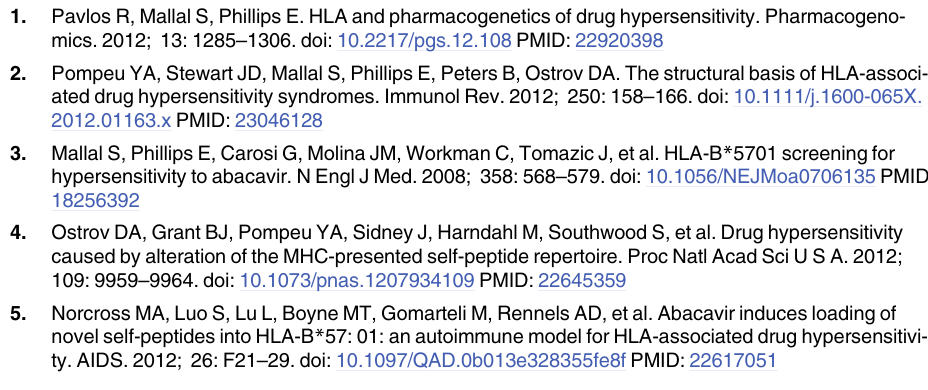
S3 Fig. Effect of seven drugs on binding specificity of HLA-B (cid:1) 57:01. Three different peptides were tested for binding to HLA-B (cid:1) 57:01 in competitive binding assays as described previously [26,27]. Values are represented as geometric mean with 95% CI of one experimental run in quadruplicates, analyzed for statistical significance by paired one-tailed parametric t-test com- values vs. vehicle; (cid:1) p < 0.05 was significant only in the presence of acyclovir. paring log IC 50 S4 Fig. Effects of abacavir and acyclovir on HLA-B (cid:1) 57:01 binding specificity. Specific pep- tides with a terminal cysteine were tested for their binding affinity in the presence of abacavir or acyclovir. Values are represented as geometric mean with 95% CI of two independent runs in triplicates, analyzed for statistical significance by Mann-Whitney U test comparing log IC values vs. vehicle; p < 0.05 was considered significant ( (cid:1) p < 0.05; (cid:1)(cid:1) p < 0.01; (cid:1)(cid:1)(cid:1) p < 0.001). S5 Fig. Effects of acyclovir on HLA-B (cid:1) 57:01 binding specificity for RARQLNYTI. Values are represented as Mean ± SEM and analyzed for statistical significance by Mann-Whitney U values vs. vehicle; p < 0.05 was considered significant ( (cid:1)(cid:1) p < 0.01). test comparing IC 50 S1 Table. List of peptides eluted in the presence and absence of acyclovir. S2 Table. Number of peptides with C terminal isoleucine in ACI treated vs. untreated